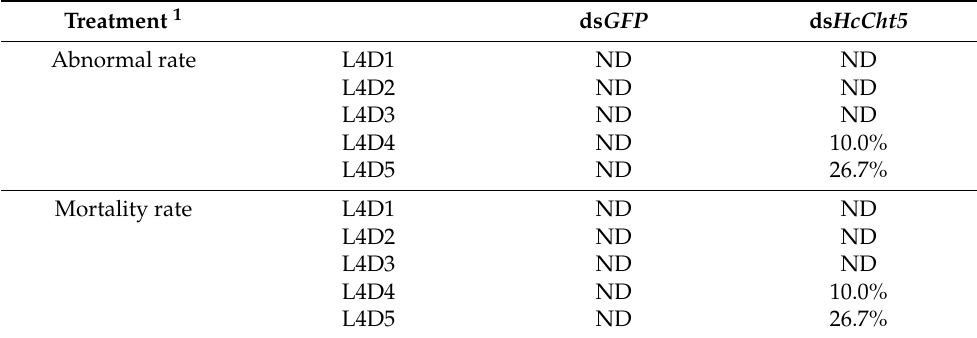
Table 2. The abnormal rate and mortality rate of H. cunea after the injection of ds HcCht5 at each day of the fourth larval stadium (L4D1 to